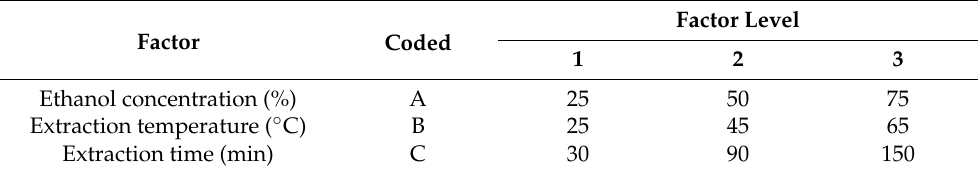
Table 5. Taguchi method factors and level selection for analyzing the antioxidant capacity of leaves of Chenopodium formosanum .